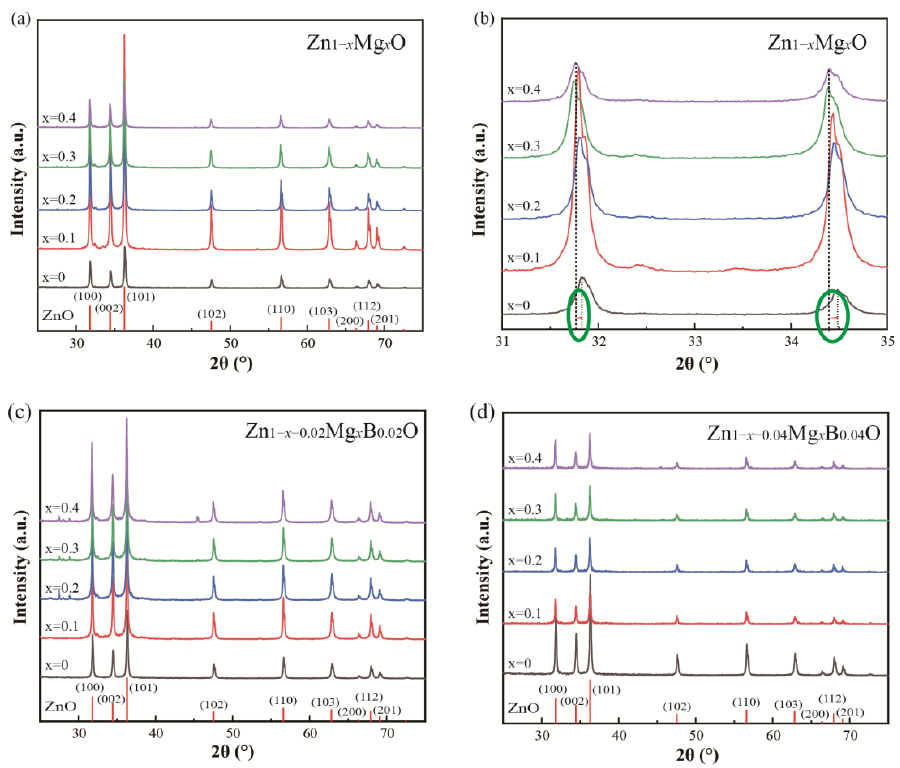
Figure 1. XRD pattern of Zn 1− x − y Mg x B y O. ( a ) Zn 1− x Mg x O; ( b ) enlarged XRD pattern of (100) and (002) plane of Zn 1− x Mg x O in ( a ); ( c ) Zn 1− x −0.02 Mg x B 0.02 O; ( d ) Zn 1− x −0.04 Mg x B 0.04 O.